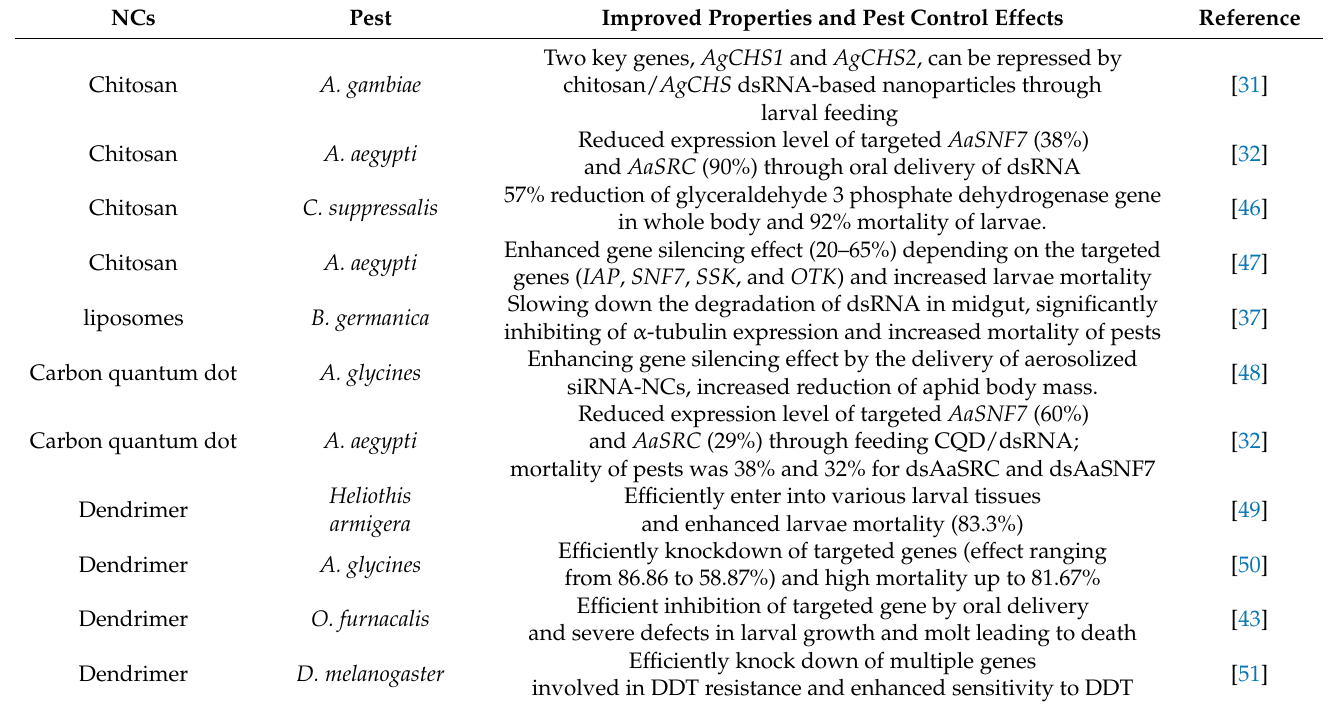
Table 1. Successful application of nanodelivery system for gene silencing and targeted control of pests.